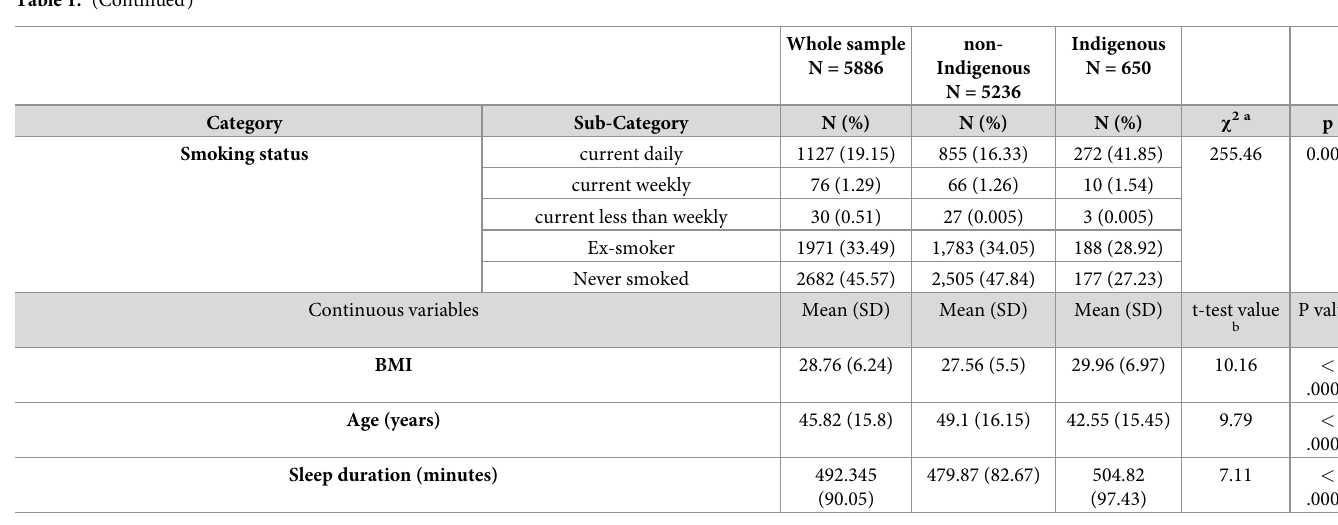
duration was accounted for in Model 4 (adjusted- R 2 = 0.056, p < 0.0001), short sleep was